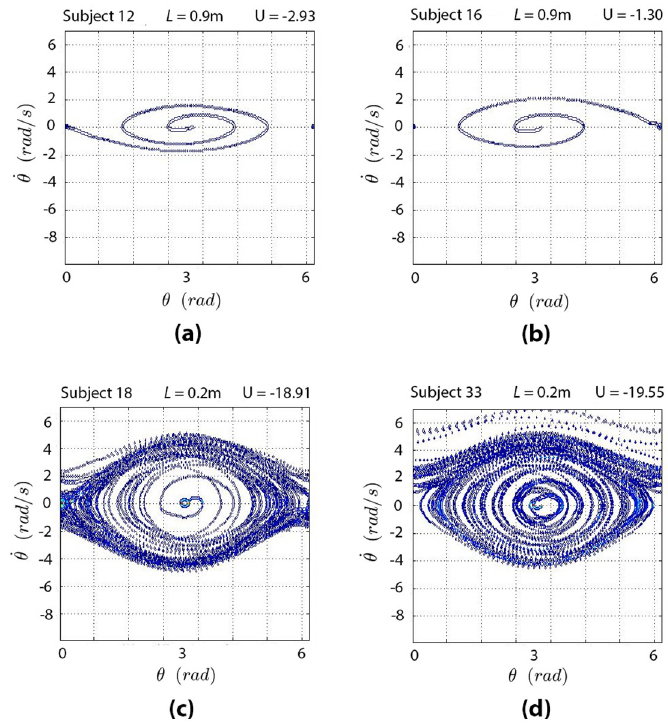
Fig 7. Support of S i within the phase space of four representative trials: Two participants swinging the longest pendulum ((a) and (b)) and other two participants swinging the shortest pendulum ((c) and (d)). Trials start at the center of the phase